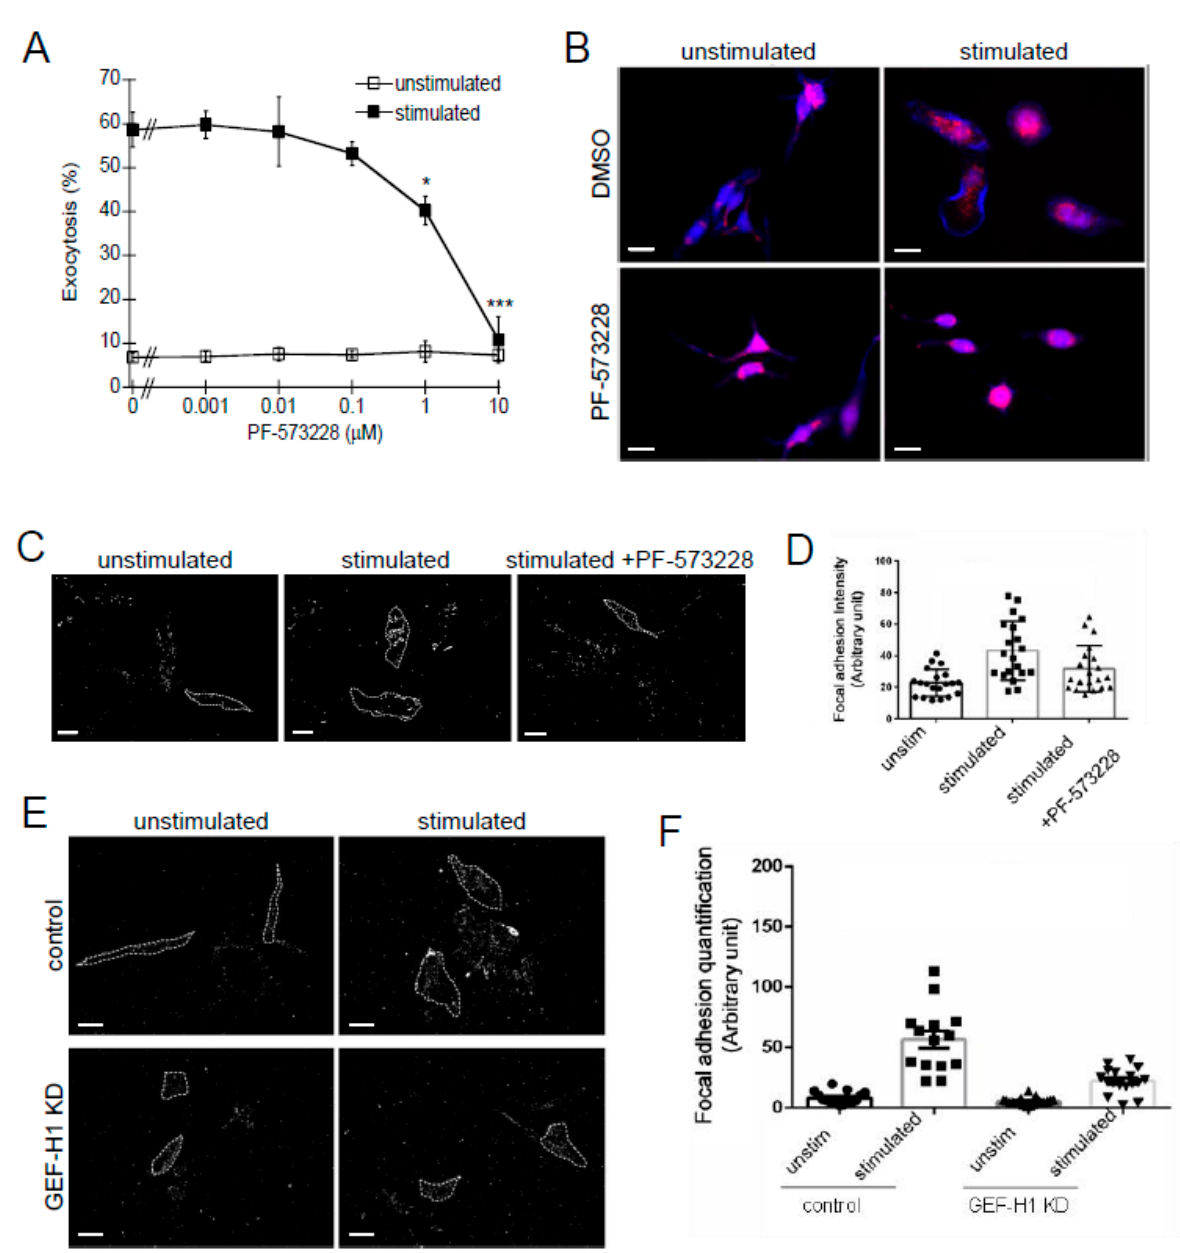
Figure 7. Involvement of focal adhesion (FA) formation in mast cell granule exocytosis. The focal adhesion kinase inhibitor, PF-573228, inhibits granule exocytosis. RBL-2H3 cells were preincubated with 1 nM to 10 µ M PF-573228 for 30 min followed by 30 min of antigen stimulation. ( A ) Degranula- tion assays showed a significant reduction in granule exocytosis when RBL-2H3 cells were pretreated with 1 or 10 µ M PF-573228 (* p = 0.0488 and *** p < 0.001 at 1 and 10 µ M PF-573228, respectively, vs. DMSO control by one-way ANOVA and post hoc Tukey’s test; n = three independent assays). ( B ) Flu- orescence microscopy of RBL-2H3 cells showing granule distribution by LysoTracker Red staining and F-actin by Alexa Fluor 405-phalloidin staining (blue). Inhibition of FA formation with 10 µ M PF-573228 prevented granule dispersion and cell spreading. Scale bar = 20 µ m. ( C ) FAs were imaged after hypotonic shock by anti-vinculin staining in unstimulated cells or antigen-stimulated cells +/ − 10 µ M PF-573228. Scale bar = 20 µ m. ( D ) Quantification of FA formation after antigen stimulation ( n ≥ 20 cells from two independent experiments). ( E ) FA formation is reduced in GEF-H1-depleted (GEF-H1 KD) RBL-2H3 cells. Scale bar = 20 µ m. ( F ) Quantification of FA formation in antigen-stimulated control and GEF-H1-depleted cells ( n ≥ 20 cells from two independent experi- ments). 3.6. GEF-H1 Is Activated in Antigen-Stimulated Mast Cells via the Fc ε RI Signaling Pathway We hypothesize that GEF-H1 transduces signals from the cell surface receptor, Fc ε RI, to downstream Rho proteins. Therefore, we next examined whether GEF-H1 activation is linked to the Fc ε RI signaling pathway. We performed assays for GEF-H1 activation using GST-RhoA-G17A for affinity precipitation [30]. RhoA-G17A is a nucleotide-free mutant of